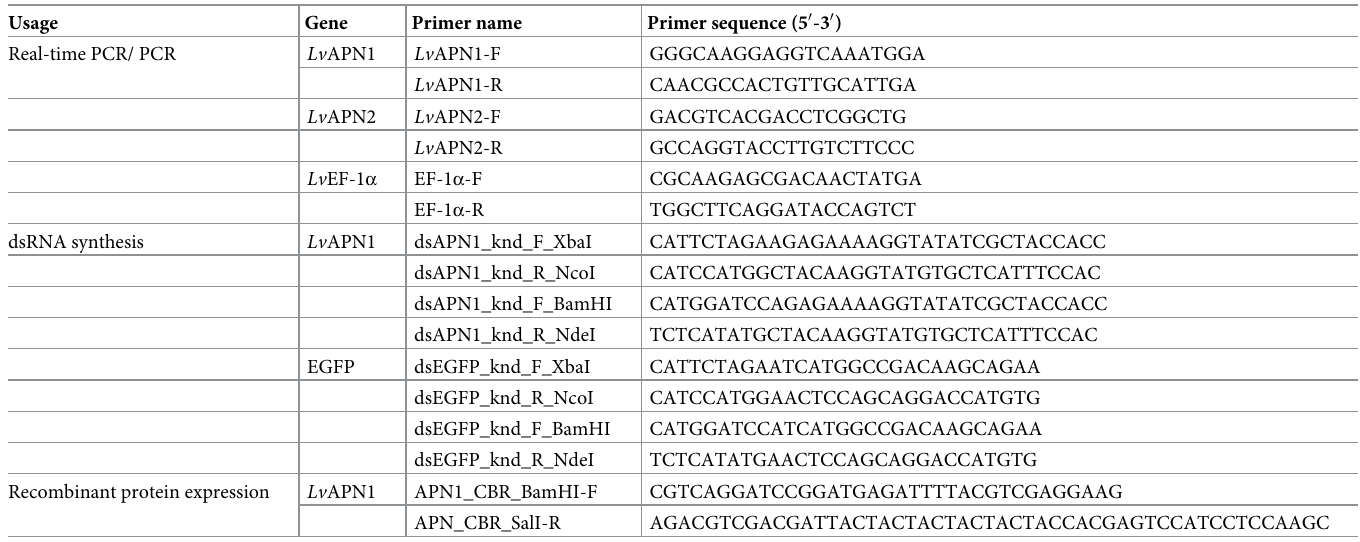
Table 1. Primers used in this study.